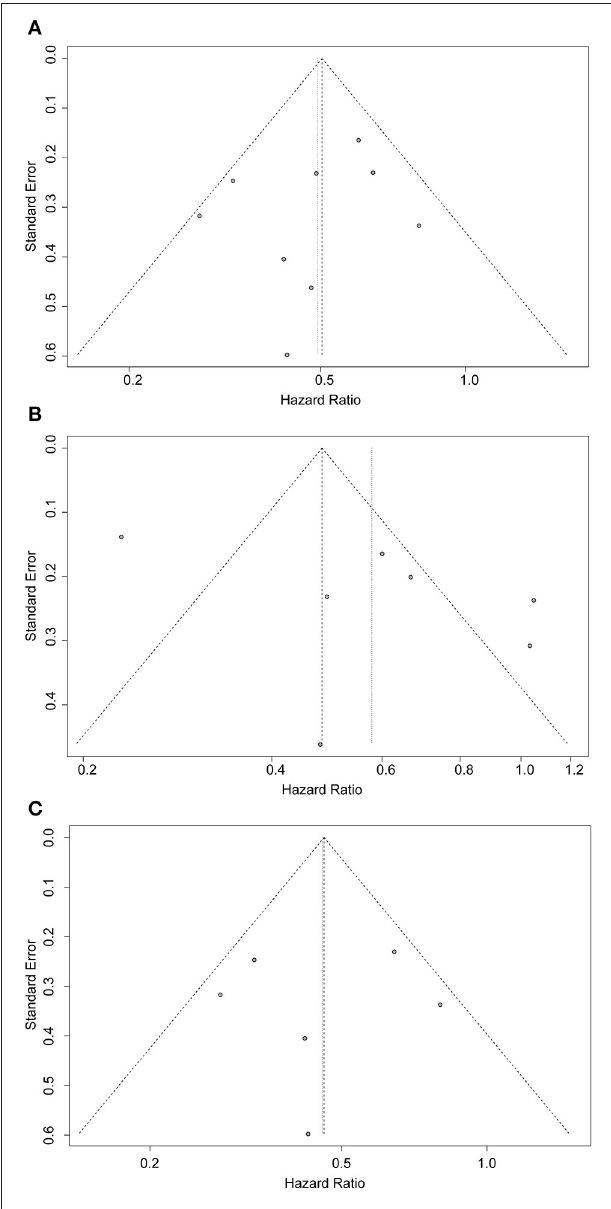
FIGURE 4 | Funnel plots for evaluating publication bias of (A) all included studies, (B) unmatched cohorts, and (C) matched